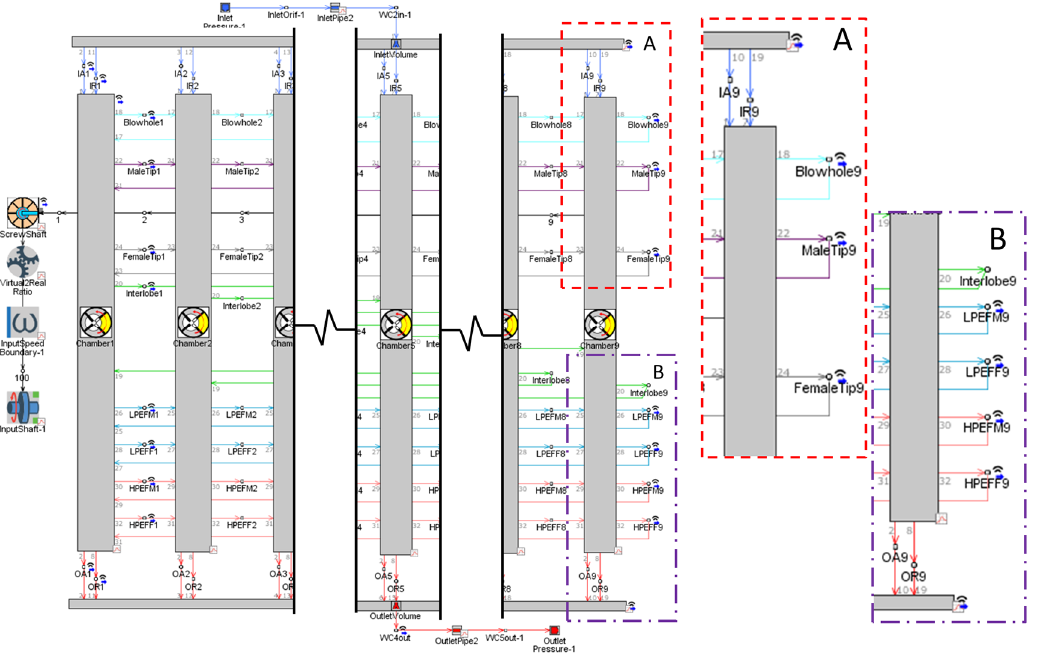
Figure 3. GT-SUITE model of GL51-M Expander; IA = inlet axial port, IR= inlet radial port, OA = outlet axial port, OR = outlet radial port, Male Tip = male rotor tip clearance leakage, Female Tip = female rotor